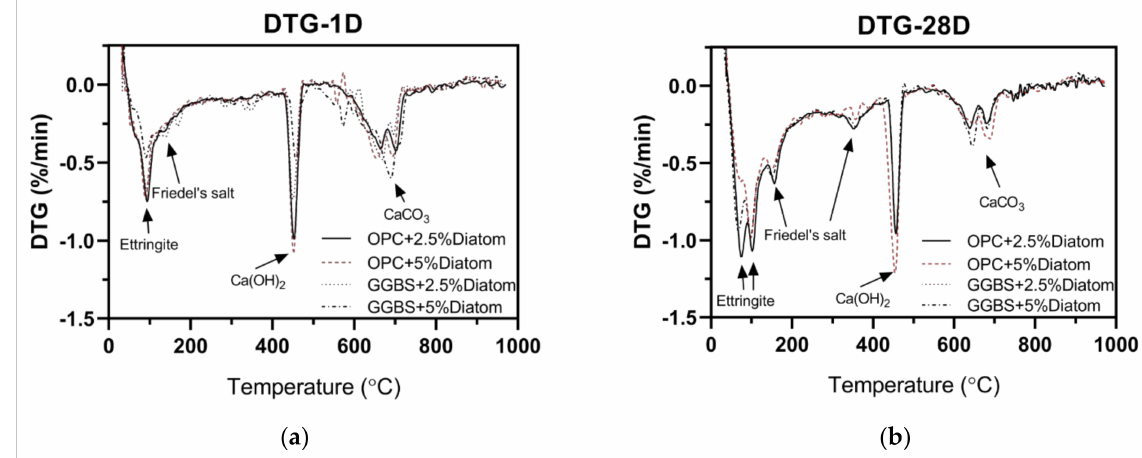
Figure 4. Effect of Diatom on the DTG results of cement paste, ( a ) 1D, ( b ) 28 D.